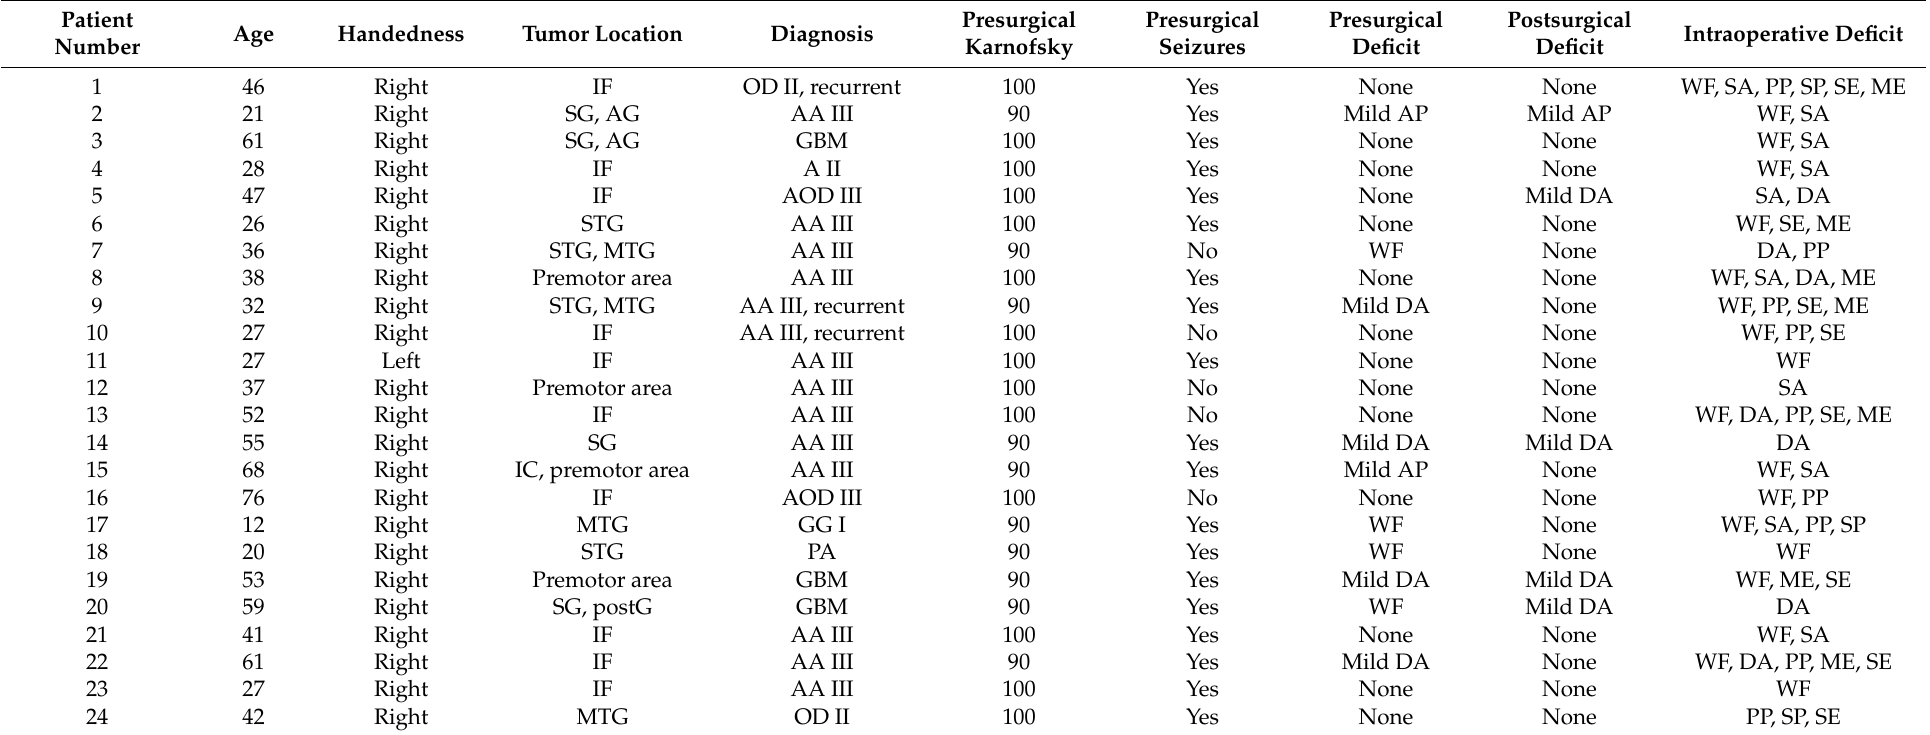
Table 1. Patients characteristics, including pre-, intra-, and postsurgical language